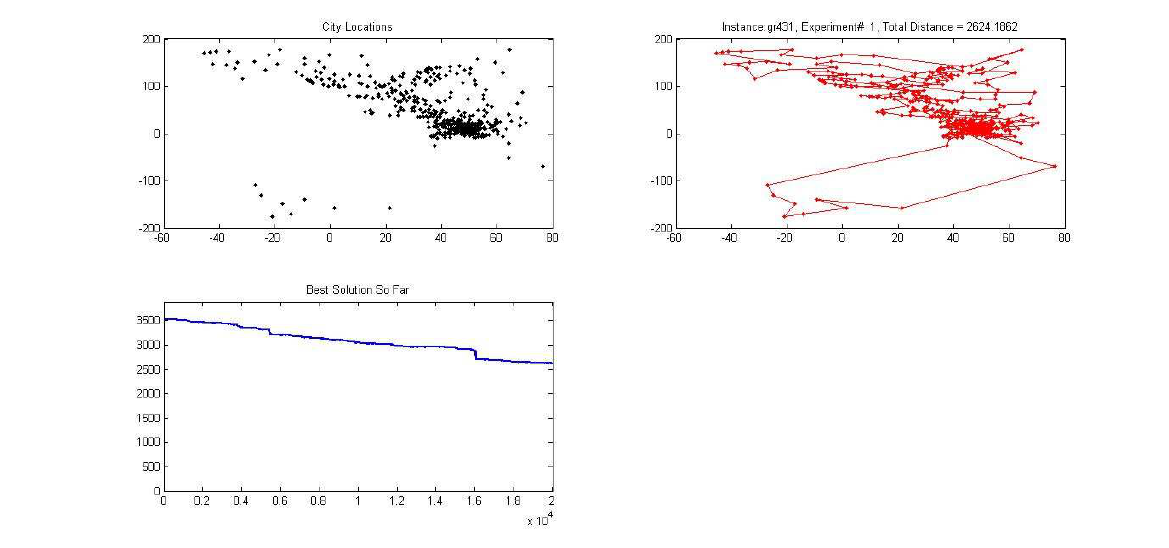
Figure 2. Graph illustrating one of the experiments on the gr431 instance of TSP (containing 431 cities) solved by the proposed BCSO algorithm. The graph depicts the city location, total distance and best solution found.